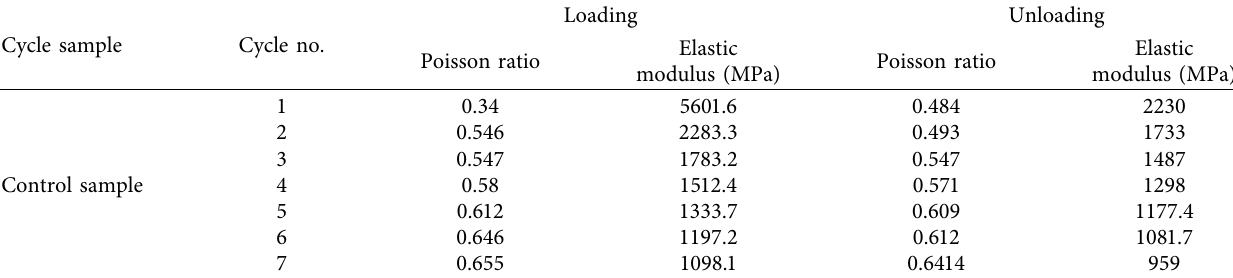
Table 5: Mechanical parameters of cycle peak (control sample).